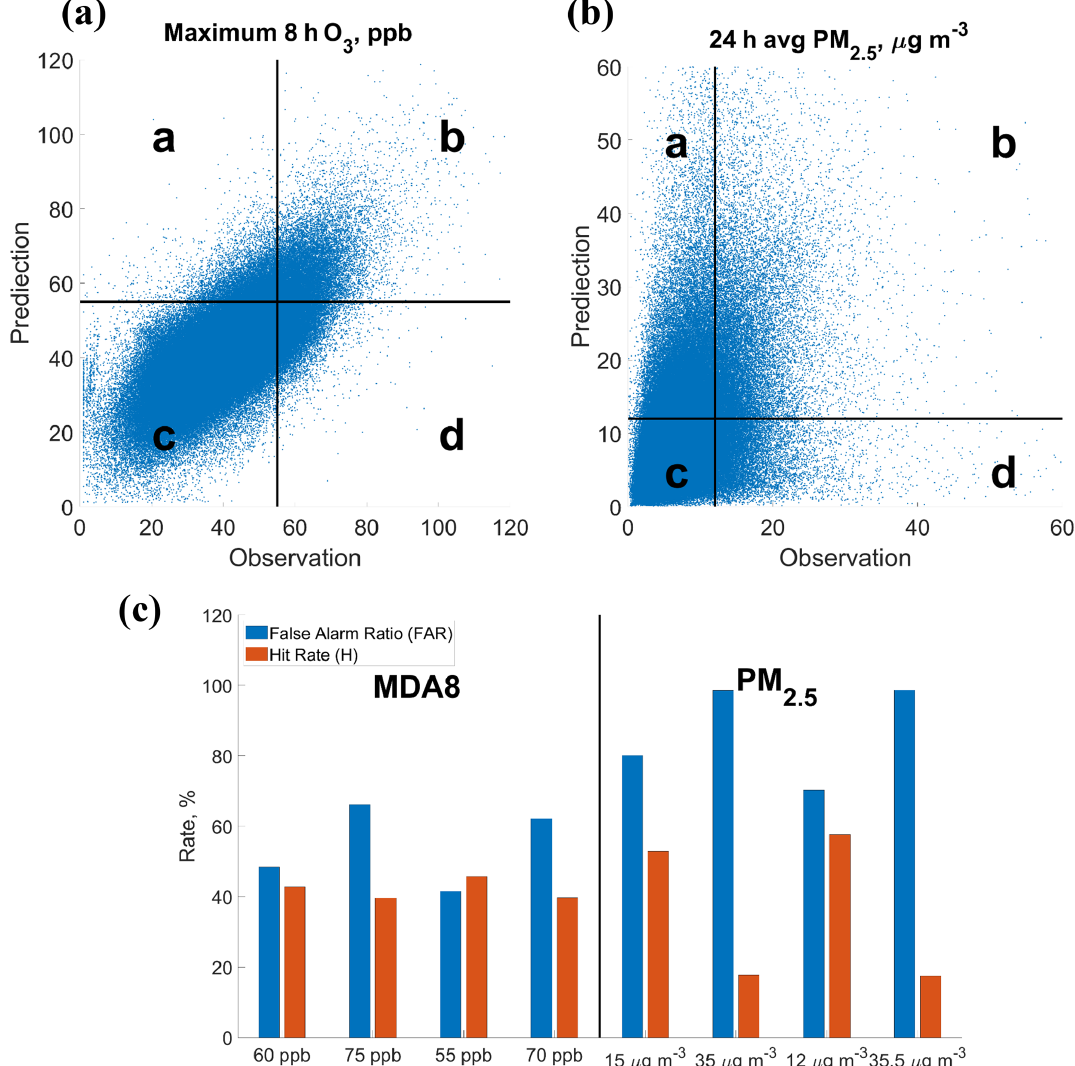
Figure 5. Categorical evaluation of MDA8 and 24h average PM 2 . 5 : (a) scatterplot of predicted and observed MDA8; the scatters are divided into four areas using the threshold of 55ppb for both observation and prediction. (b) Scatterplot of predicted and observed 24h average PM 2 . 5 ; the scatters are divided into four areas using the threshold of 12µgm − 3 for both observation and prediction. (c) False alarm ratio (FAR) and hit rate (H) in four categories for forecasts of MDA8 and 24h average PM 2 . 5